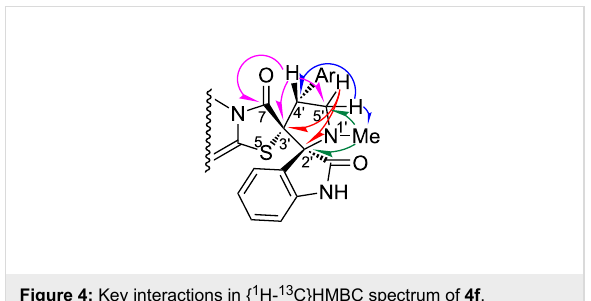
Figure 4: Key interactions in { 1 H- 13 C}HMBC spectrum of 4f .